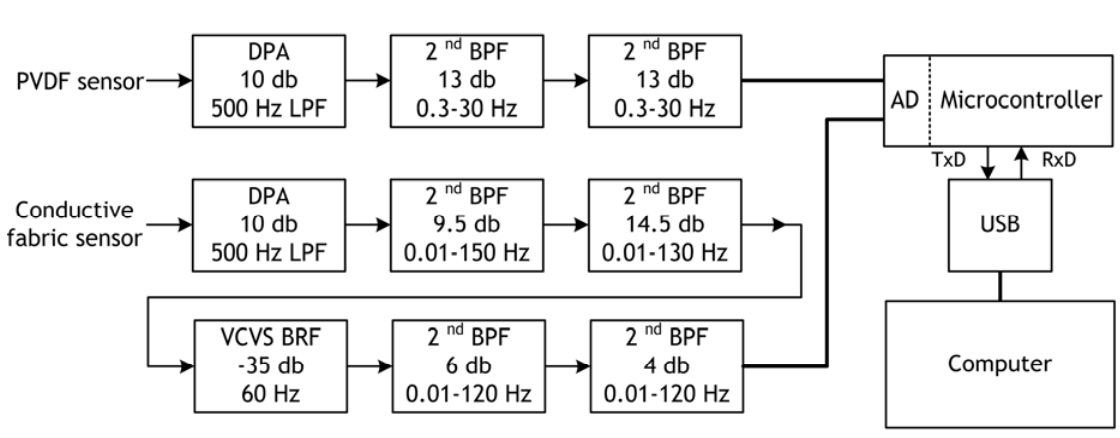
Figure 3. Block diagram of the signals acquisition circuits for PVDF film and conductive fabric sensors.